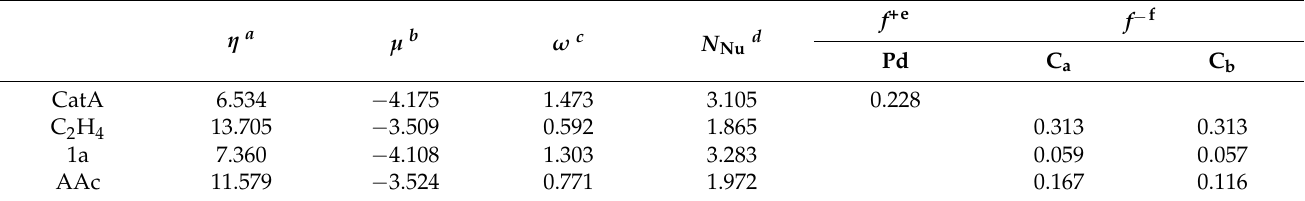
Table 6. The global reactivity index (GRI) and Fukui function values for some